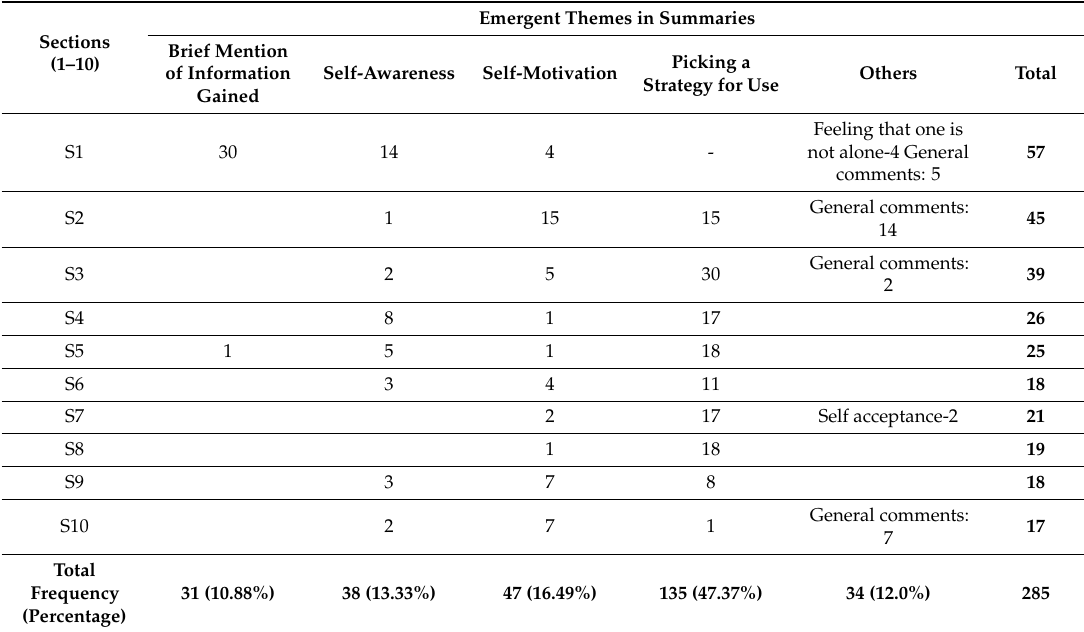
Table 7. Emergent themes in session summaries provided by participants. (Number of summaries = 285).